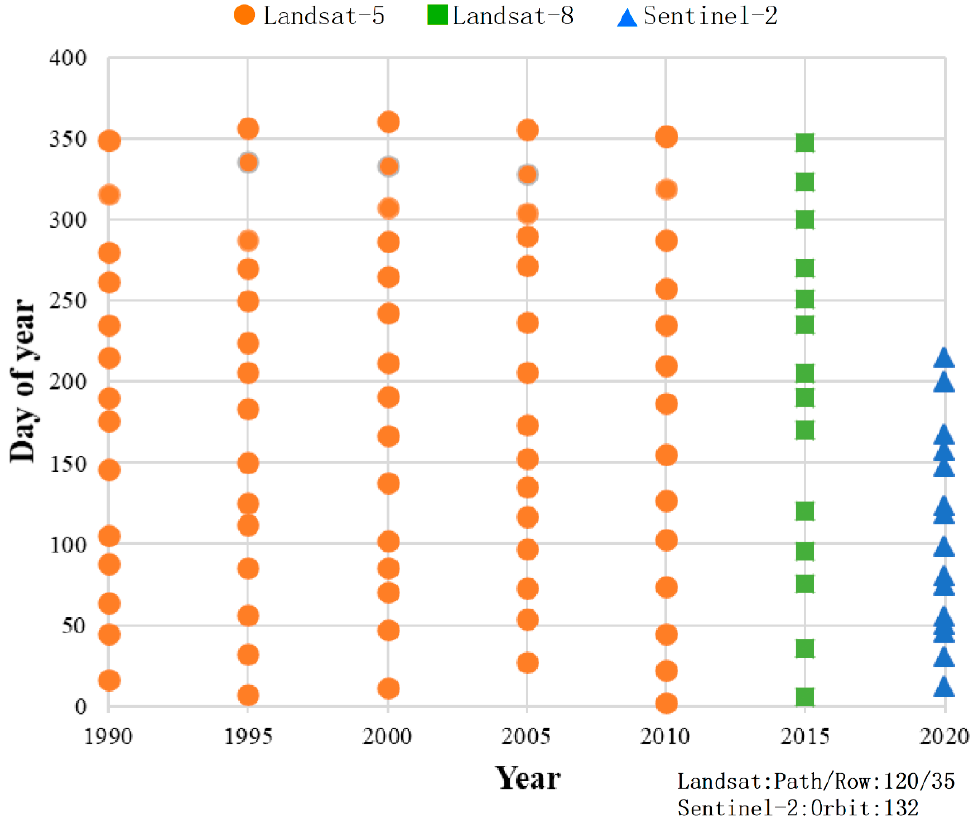
were obtained from USGS, and the images included those captured by the OLI sensors and TM sensors. The OLI sensor included 9 multispectral bands and 1 panchromatic band, and the spatial resolution after fusion can reach 15 m; the TM sensor included 6 multispectral bands with 30 m spatial resolution and the revisit period was 16 days for both sensors. The selected images had limited cloud coverage and high quality in the bay region. In addition, several Chinese GF-2 remote sensing images in 2020 were also included, with a spatial resolution of up to 1 m, which assisted in the collection of classified samples together with the high-resolution images in Google Earth.